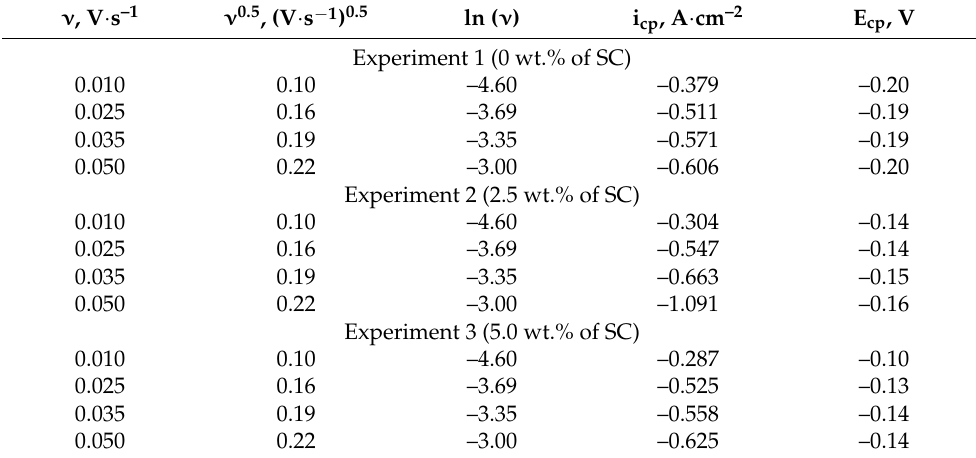
Table 2. Kinetic parameters of Al reduction at W electrode in the 85LiF-15AlF 3 melts with varying spent catalyst content at 740 ◦ C.